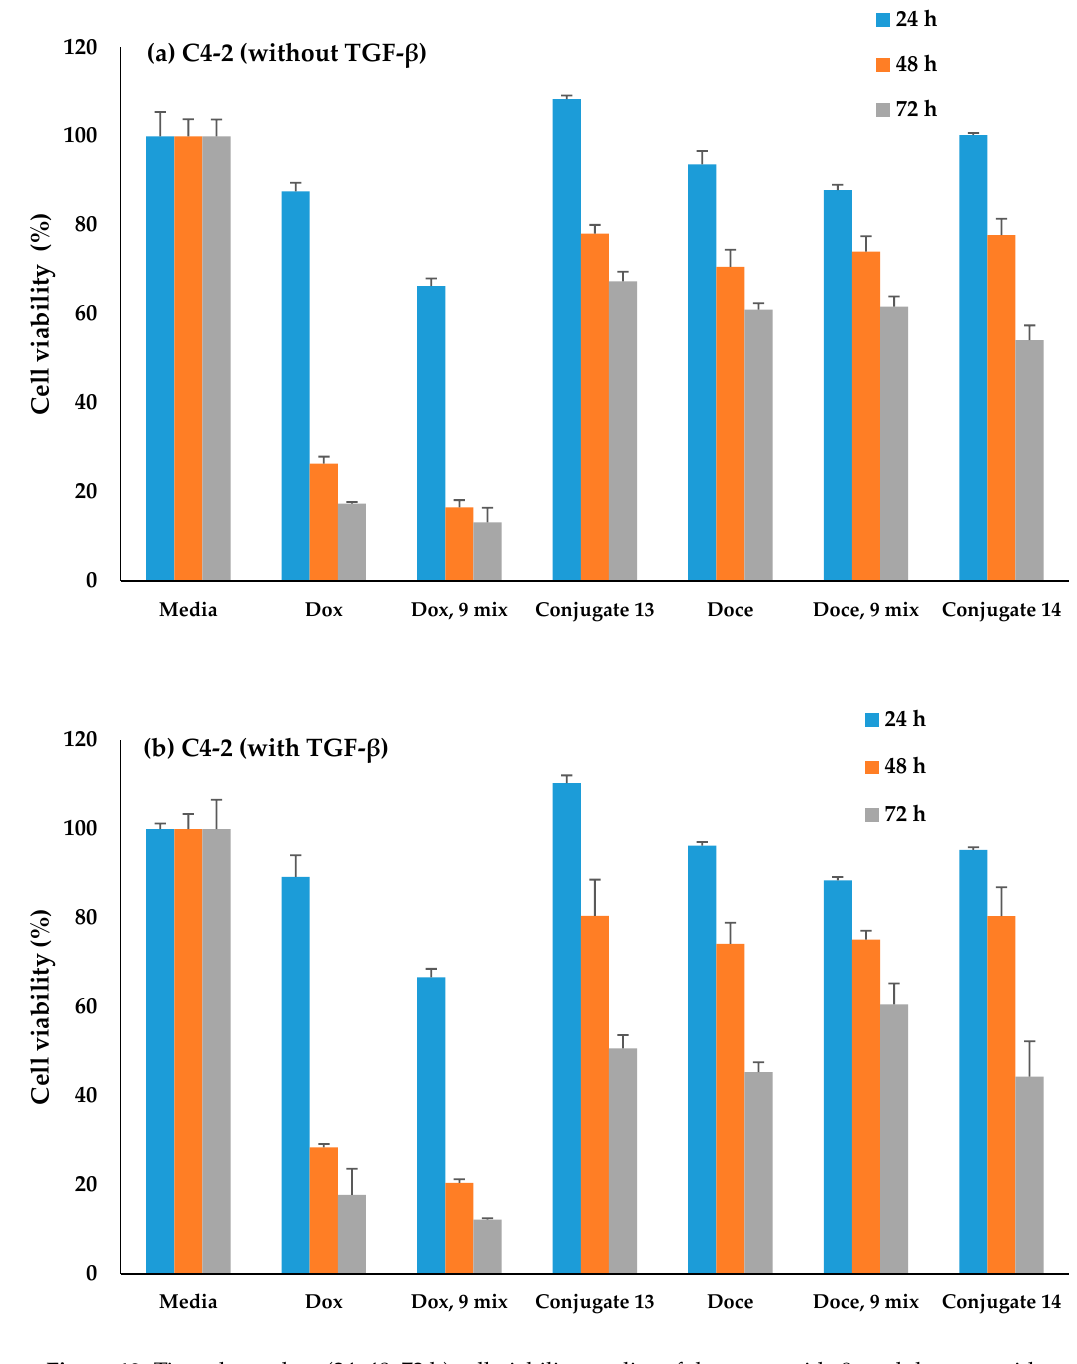
Figure 10. Time-dependent (24, 48, 72 h) cell viability studies of drugs, peptide 9, and drug–peptide conjugates 13 , 14 , and physical mixtures of drug and peptides using MTS on ( a ) prostate C4-2 cell line, a subline of LNCaP without TGF- β , ( b ) with TGF- β treatment.